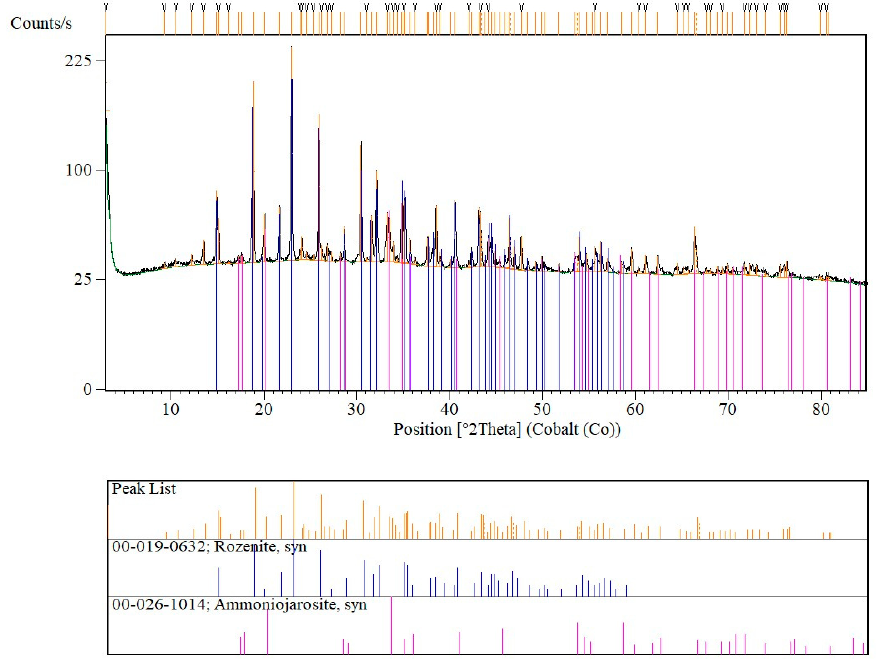
Figure 5. X-Ray powder diffraction diffractogram of sample 1: rozenite and ammoniojarosite have been clearly identified.